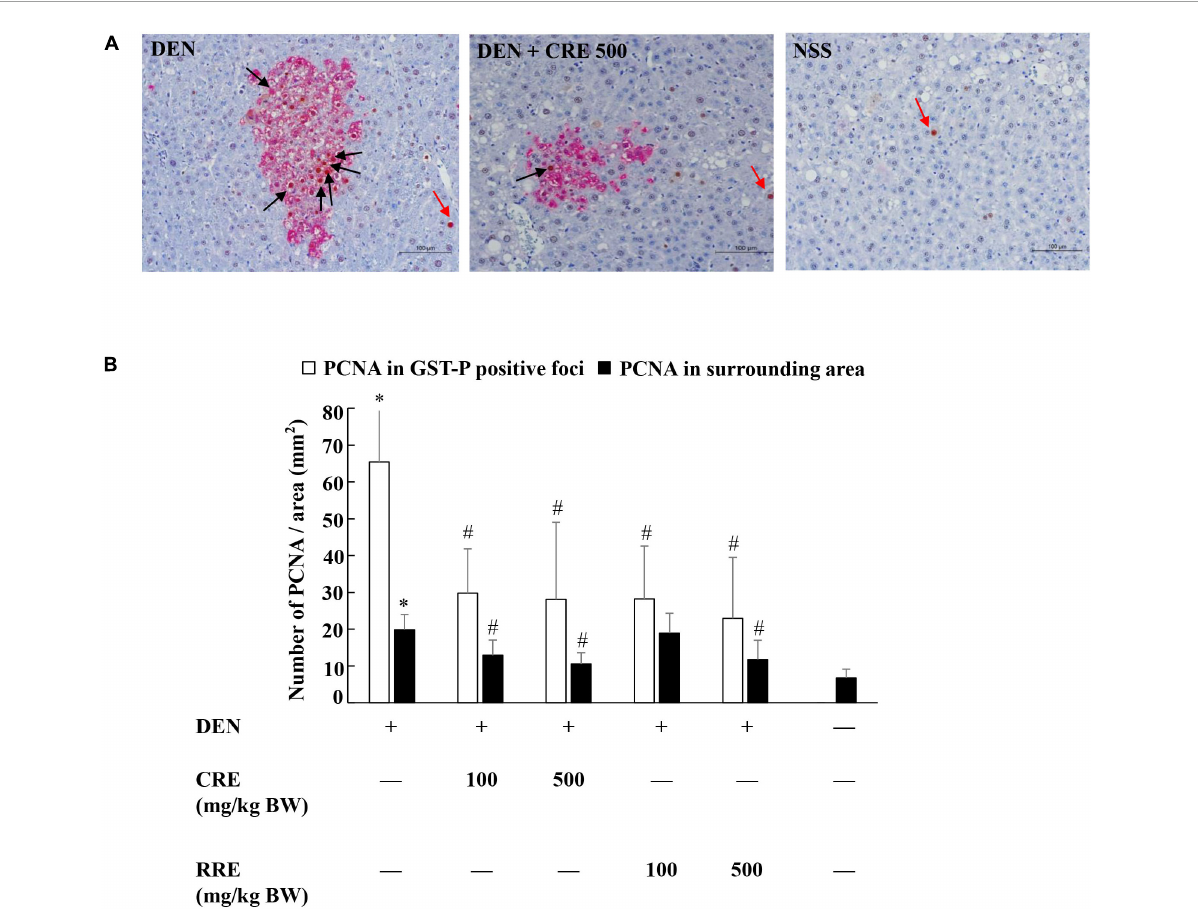
FIGURE4 Effect of cooked glutinous purple rice extracts on cell proliferation in rat livers. (A) PCNA positive hepatocytes in liver tissue, (B) number of PCNA positive hepatocytes in GST-P positive foci and surrounding areas. Black arrow: PCNA-positive hepatocytes in GST-P positive foci and red arrow: PCNA-positive hepatocytes in the surrounding area. DEN, diethylnitrosamine; CRE, cooked glutinous purple rice extrac; RRE, raw glutinous purple rice extract. Values are expressed as mean ± SD. ∗ Significantly different from the negative control group ( p < 0.05). # Significantly different from the positive control group ( p <